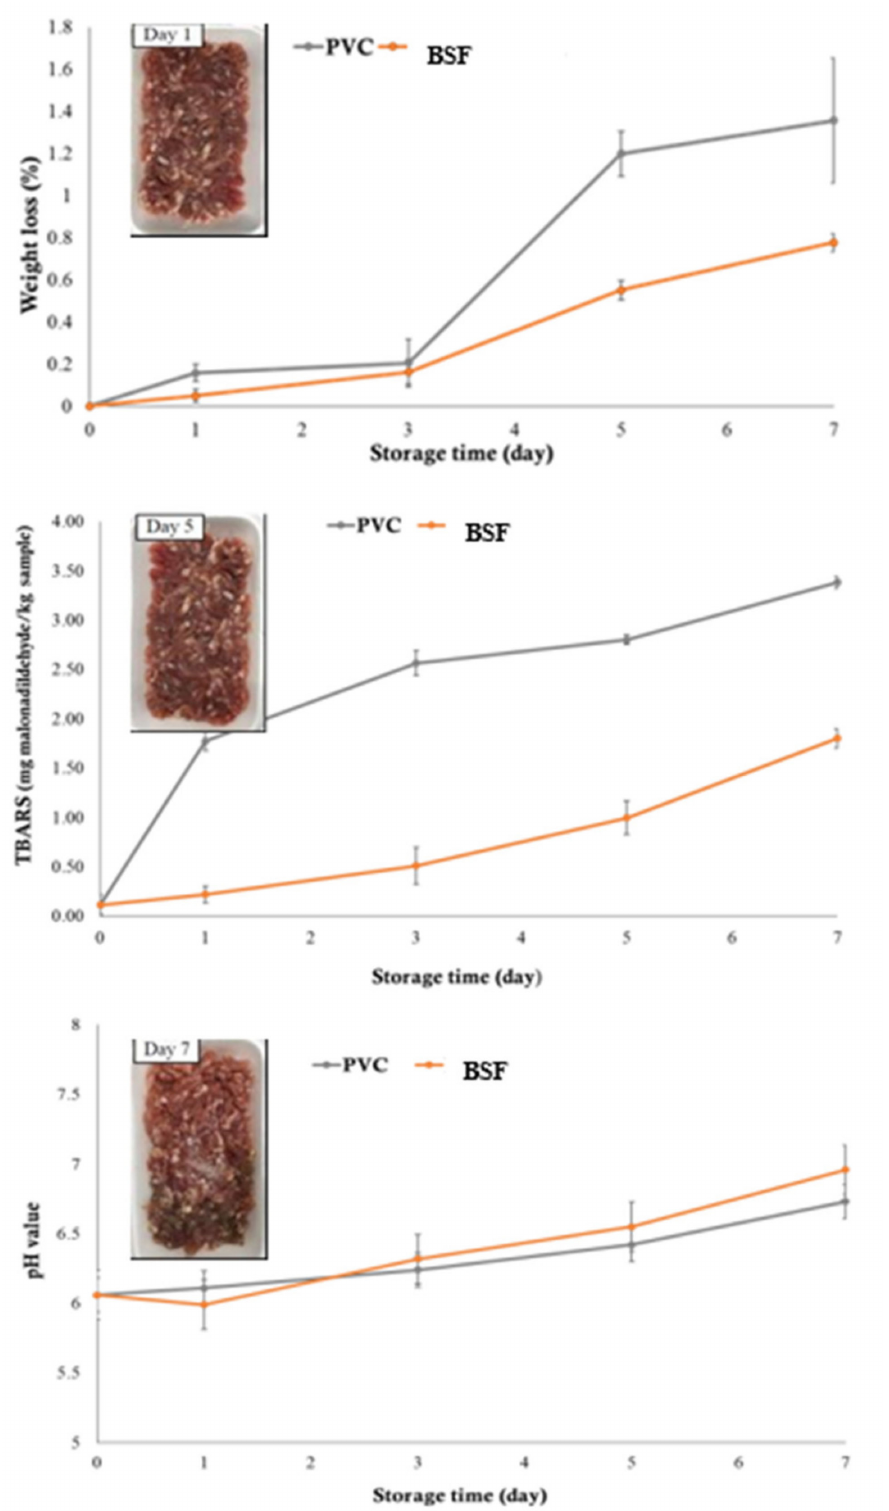
Figure 3. Weight loss, thiobarbituric acid reactive substances (TBARS), and pH changes of the wrapped minced pork with PVC and BSF during refrigerated storage for 7